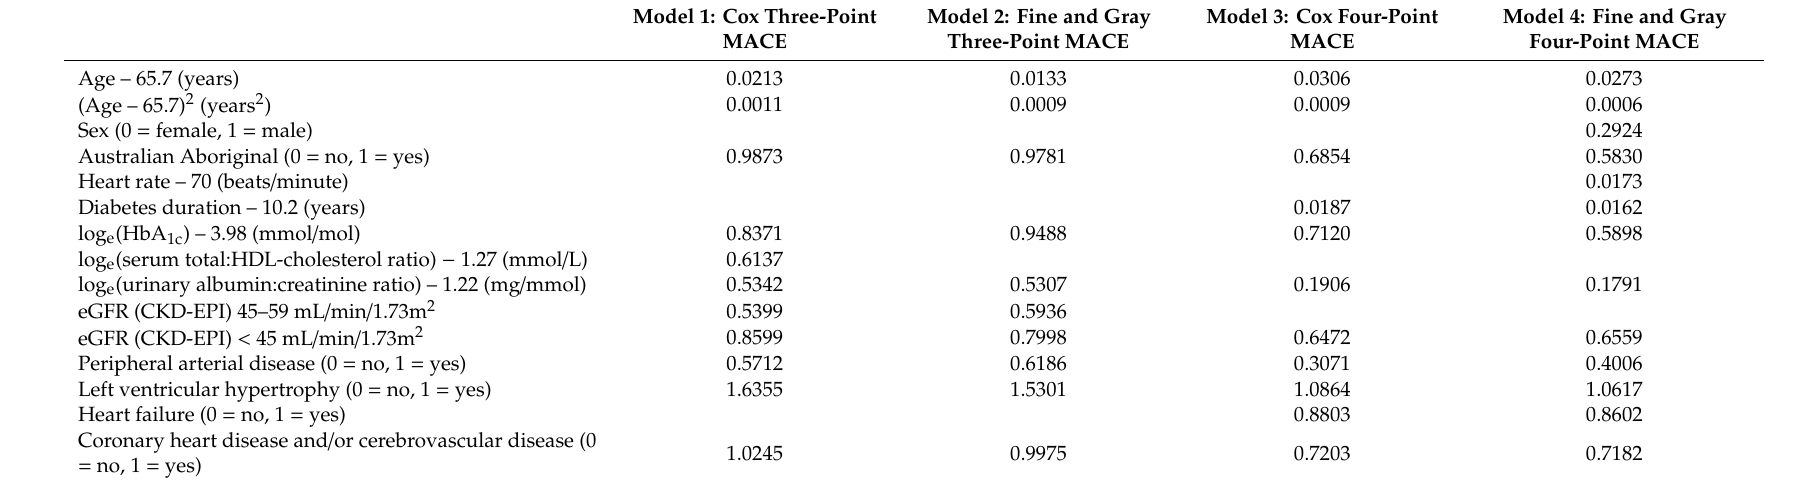
Table 2. Cox and Fine and Gray competing risk regression coe ffi cients for the variables in the five-year cardiovascular disease risk models for three-point major adverse cardiovascular events (MACE) and four-point